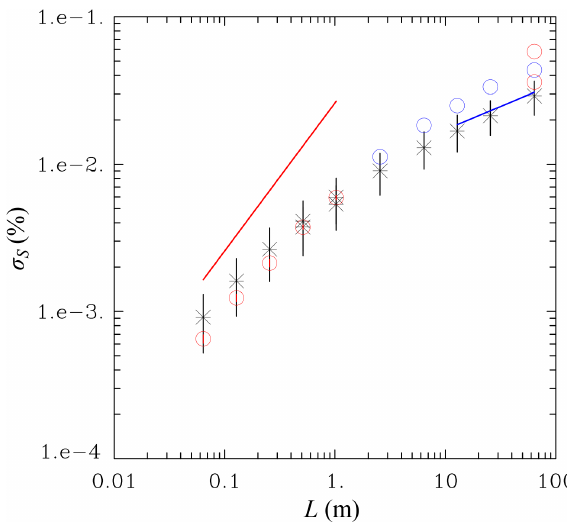
Figure 10. Standard deviation of supersaturation fluctuations in DNS and scaled-up DNS (color circles) and the stochastic model (black stars). Vertical lines for the stochastic model represent vari- ability among individual realizations. For DNS and scaled-up DNS, the variability comes from different multiplicity for super-droplets; it is not shown as it is smaller than the symbol size. Red circles in the left half are for DNS with three different multiplicities as in Fig. 4. Blue circles are for 256 3 scaled-up DNS simulations. Red circles for L = 64m are for 128 3 (lower symbol) and 512 3 (upper symbol) scaled-up DNS simulations. The two data points for the stochas- tic model with L = 0 . 512m and L = 1 . 024m come from applying TKE from either DNS or scaled-up DNS. The red and blue lines show results from the stochastic model without droplets and with the quasi-equilibrium supersaturation, respectively. See text for de-